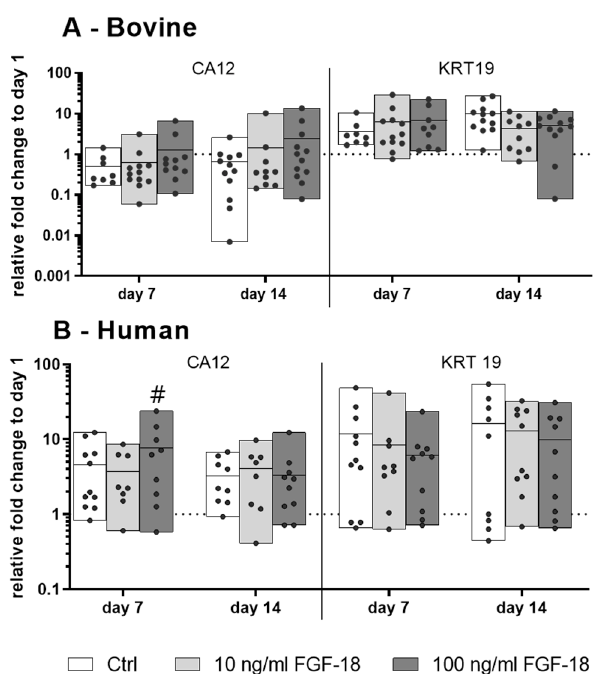
Figure 2. Relative mRNA expression of NP cell marker genes carbonic anhydrase 12 (CA12) and keratin 19 (KRT19) of ( A ) bovine (healthy) nucleus pulposus cells and ( B ) human (mildly degenerated) nucleus pulposus cells encapsulated in FBG-HA hydrogel and stimulated with 10 or 100 ng/mL FGF-18 (FGF-18 ∆ 51 for bovine and FGF-18 WT for human NP cells), after 7 or 14 days of culture. Data were normalized to the expression level of cells at day 1 in hydrogel culture. n = 4, # p < 0.05 vs. day 1.